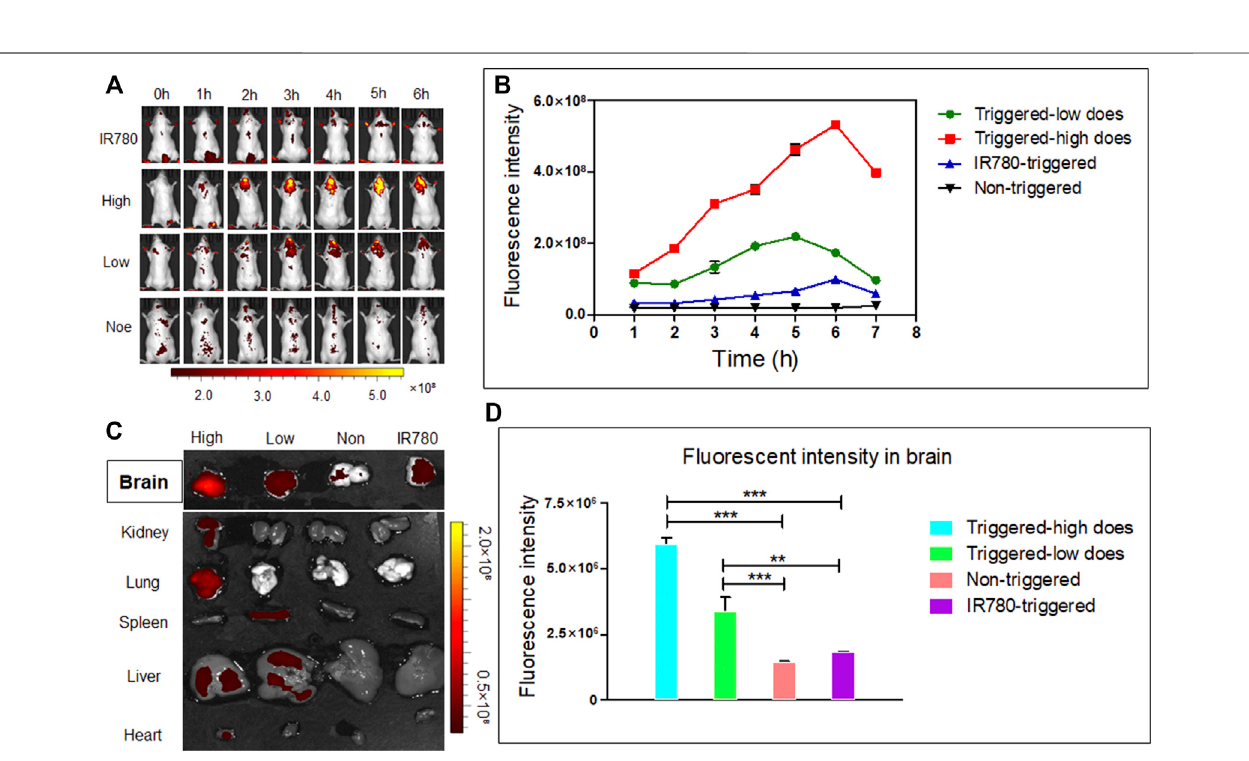
FIGURE8| Invivo distributionandbrainreleaseofAUTNPsinmice: invivo fl uorescenceimages (A) , invivo fl uorescencequantitativeanalysisofbraincontactsites (B) , fl uorescence images of the brain and other primary organs (C) , quantitative fl uorescence analysis of the brain (D) . The ** p < 0.01; and *** p < 0.001.